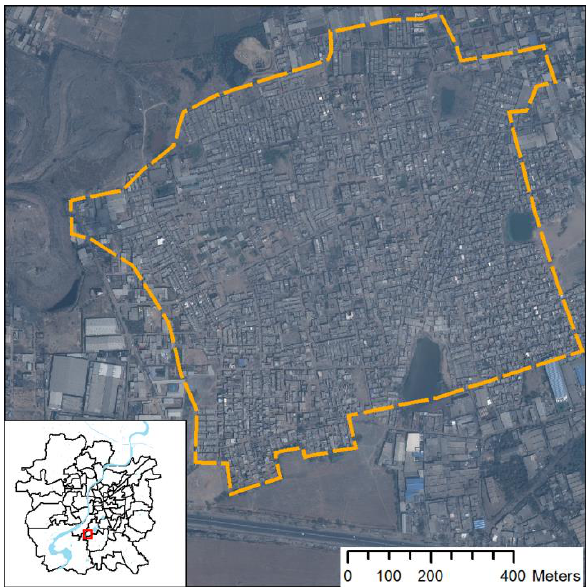
Figure 4: Scatterplot